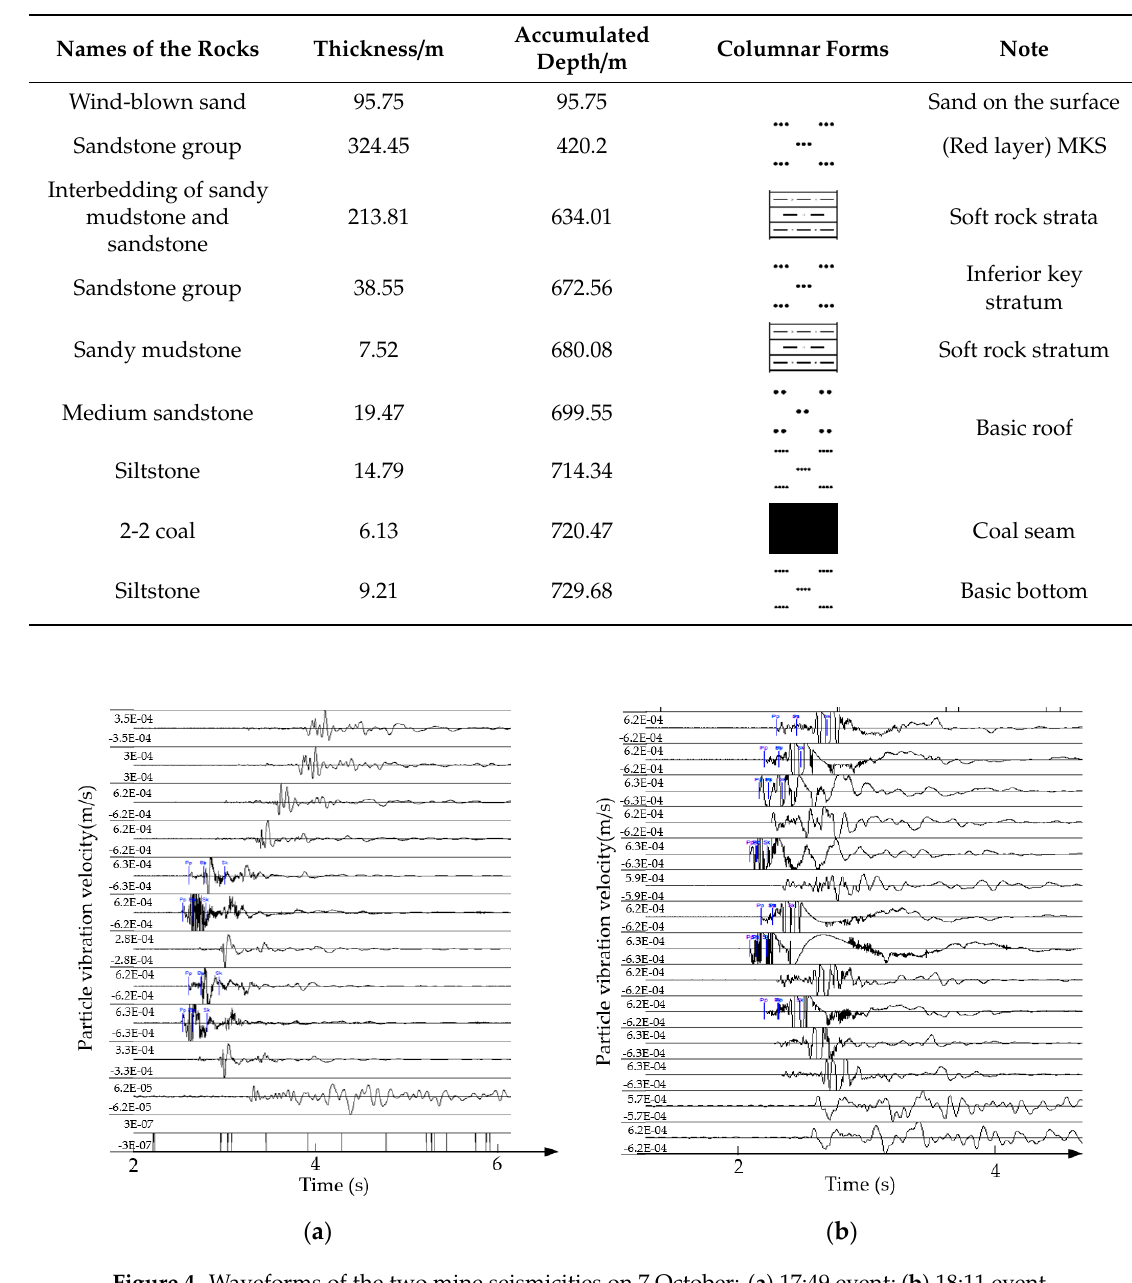
Table 1. Structural characteristics of rock strata above 2-2 coal seam.